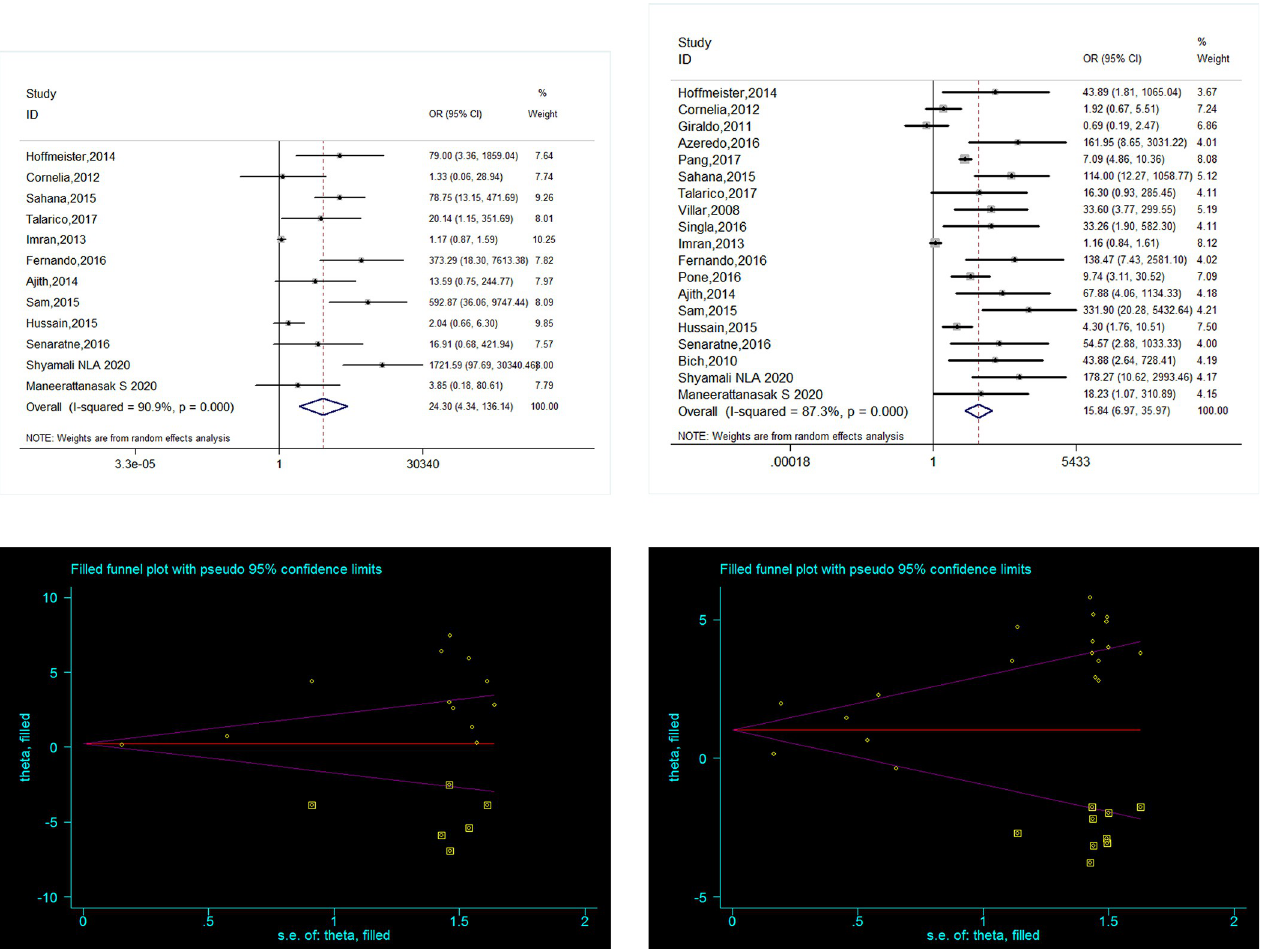
Fig 3. Association between plasma leakage and SDD. (A, B) Forest plot for pleural effusion, ascites respectively DF vs SDD, OR: odds ratio. (C, D) Funnel Plots for pleural effusion, ascites respectively (Trim and Fill) DF vs SDD, SE: standardized error.